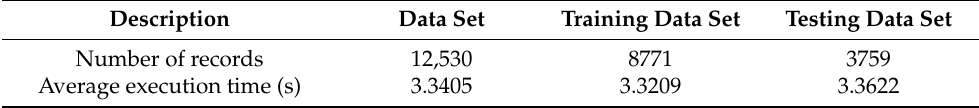
Figure 5. The CPU time distribution of testing data set. Table 3. Training and testing data